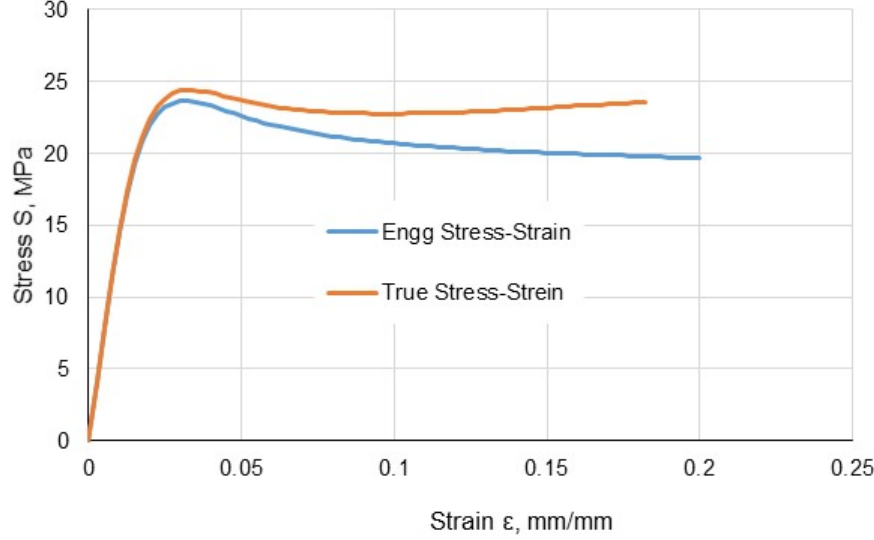
Figure 12. True stress as a function of true strain for methacrylic adhesive.